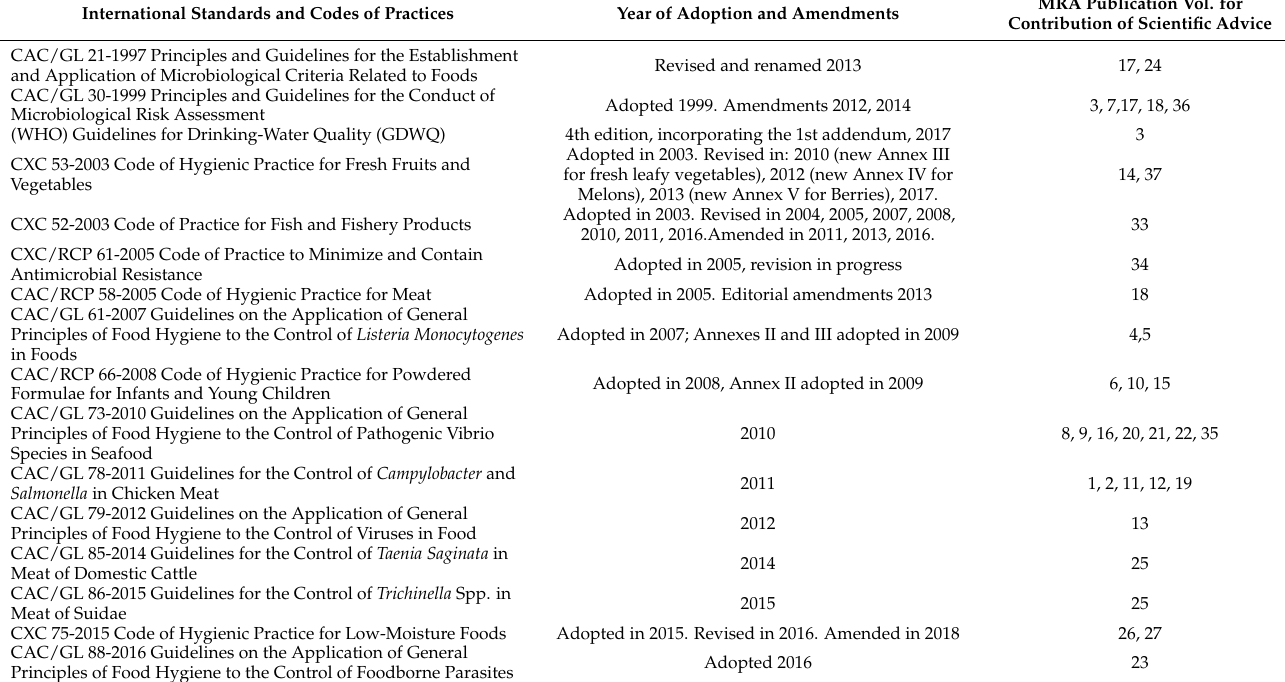
Table 3. International standards informed by scientific advice provided by JEMRA and captured as part of the MRA series